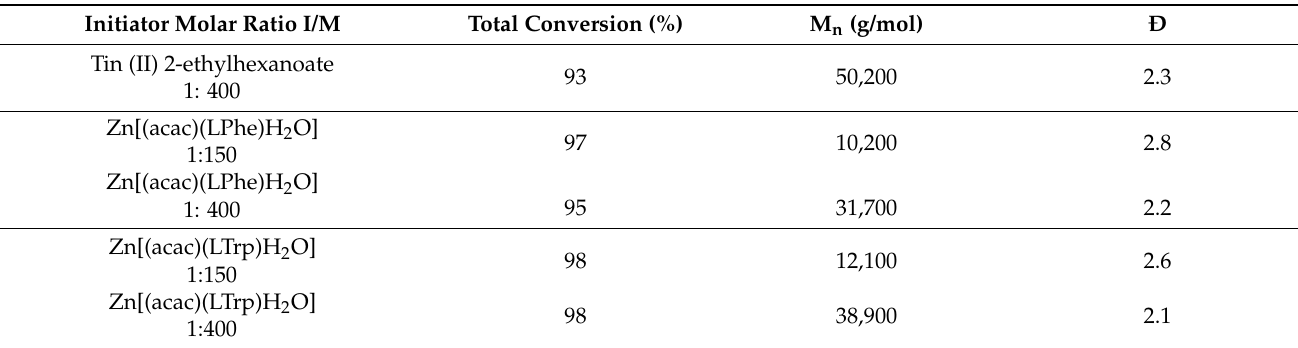
Table 3. Properties of the tested